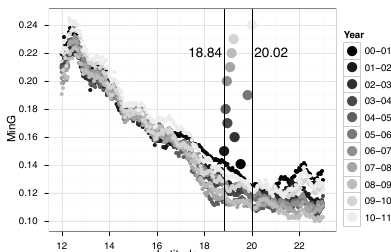
Figure 7: Latitudinal gradients of vegetation phenol- ogy along the transect (a) LOS; (b) LIG. The equations show the phenological metrics as a function of latitude. The vertical lines are the temporal standard deviations of these latitudinal gradients.